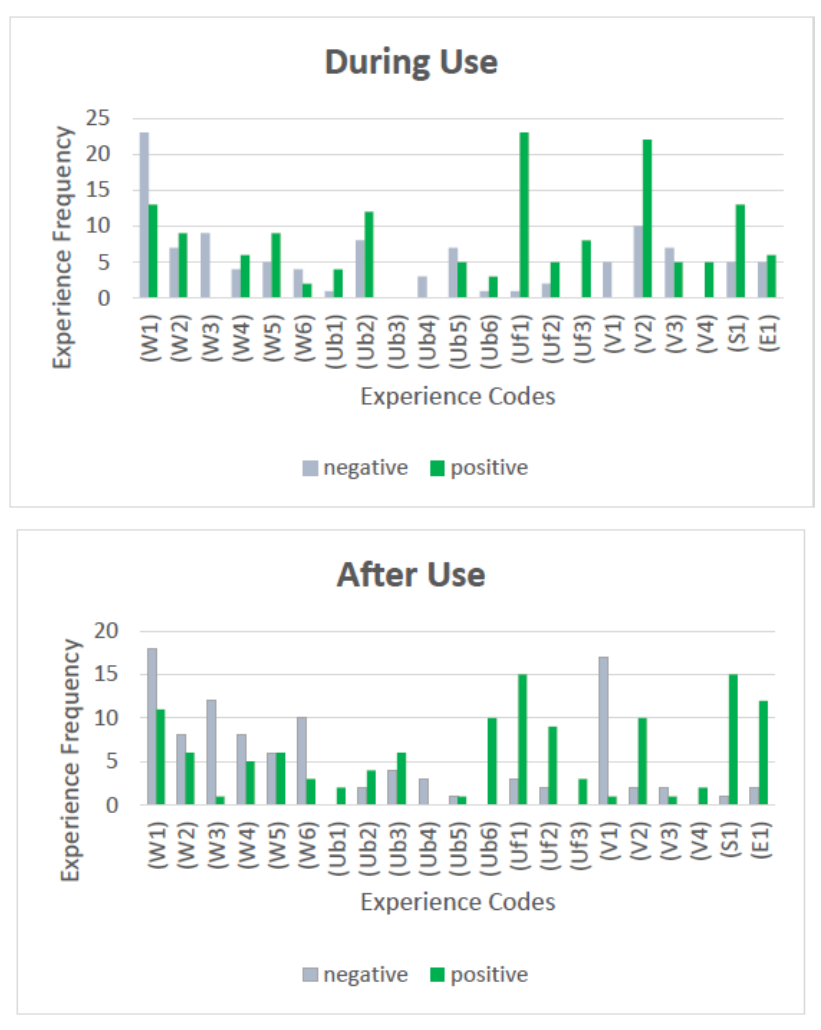
Figure 6. Positive and negative experiences during use and after use.